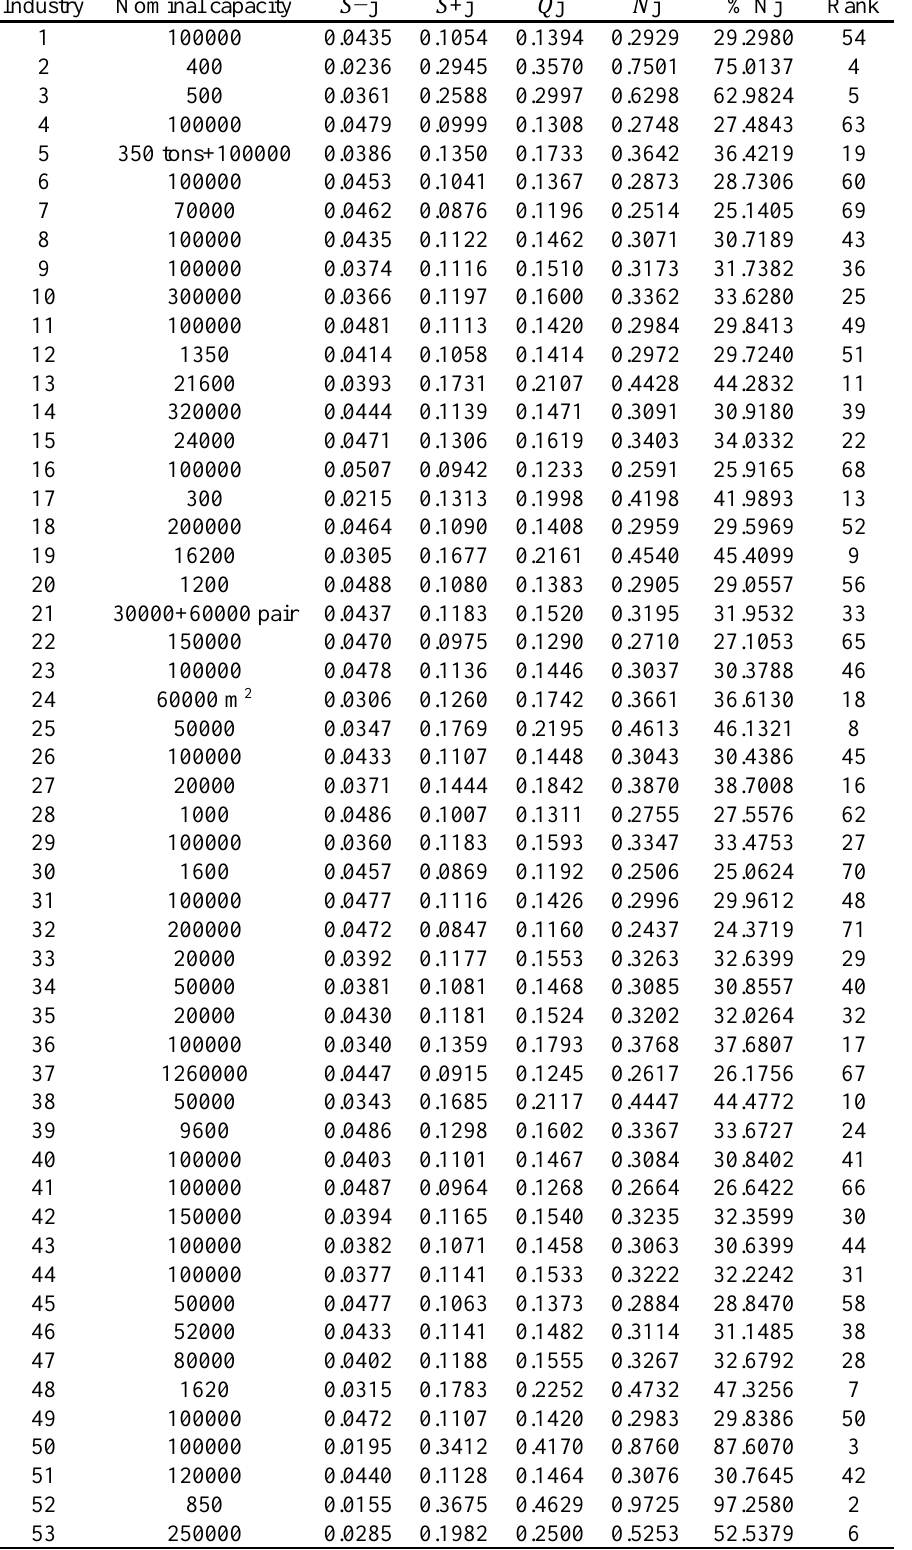
Table 5. Ranking